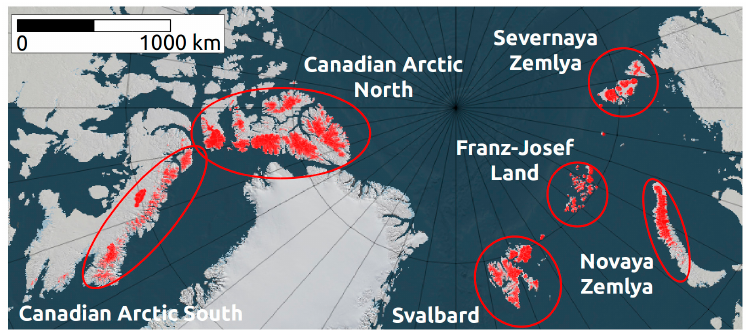
Figure 1. Study regions with glacierized areas (in red) according to RGI 5.0 [33].